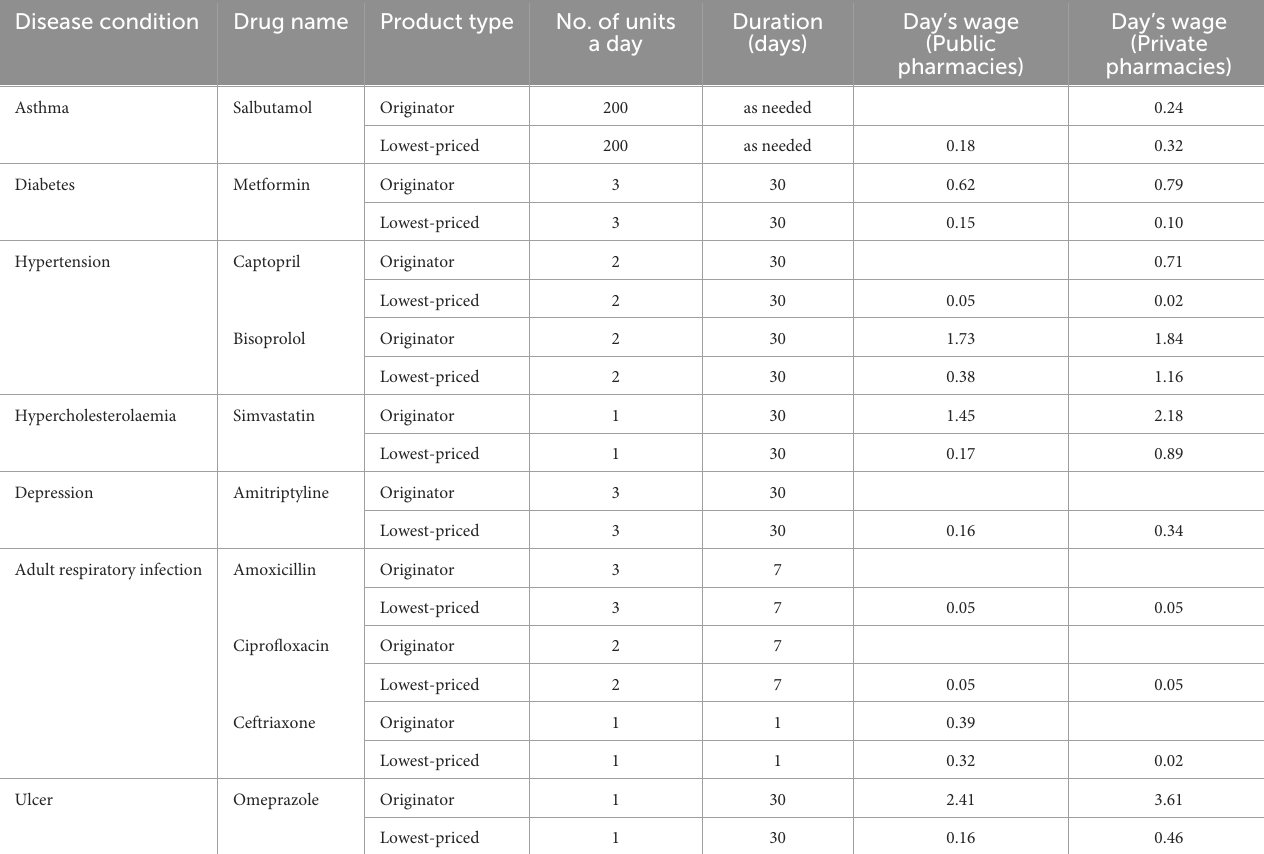
TABLE 6 Affordability of core medicines for common diseases in the public sector and private sector. Disease